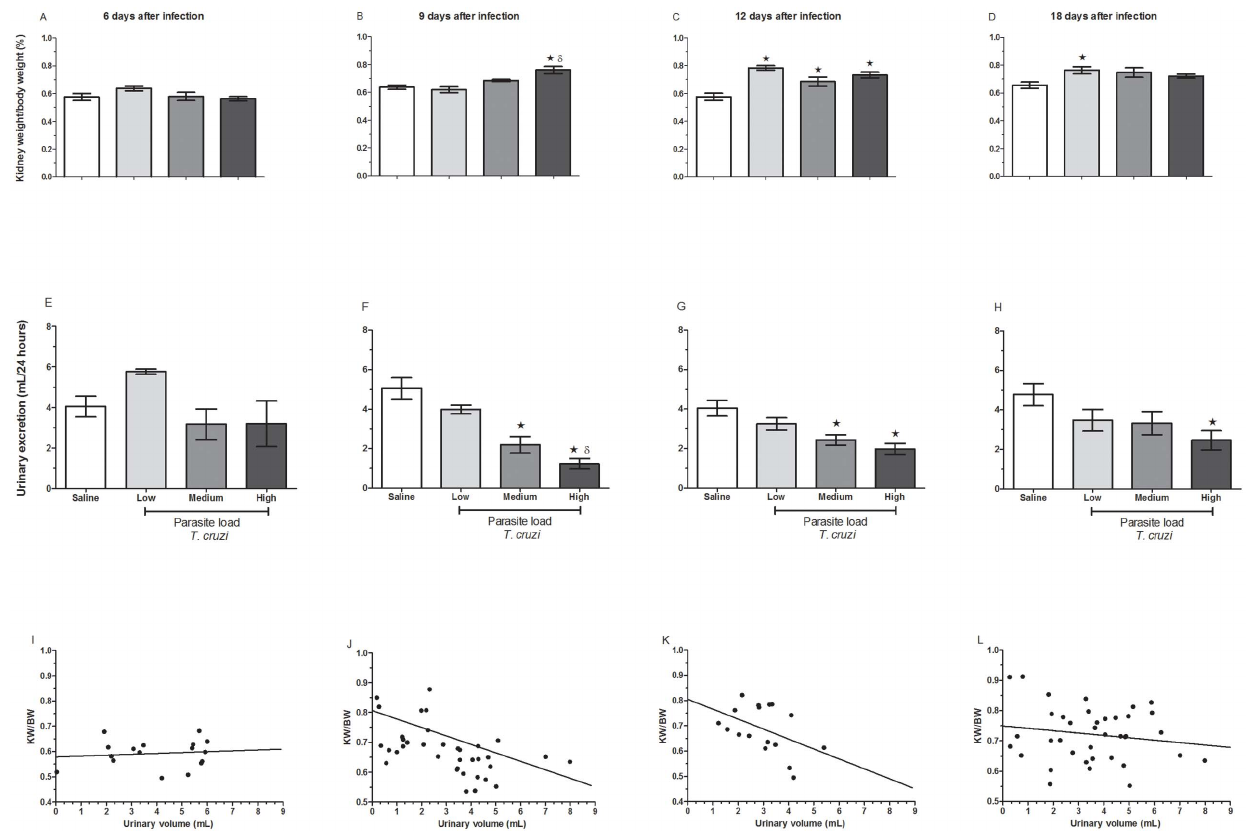
Figure 2. Determination of the urine excretion (24 hours) and the index between the kidney and body weight. The index between the kidney and body weight (A–D), urine excretion (E–H) and the correlation between the index and urine excretion (I–L) were evaluated as indicators of renal lesions. The bodies and kidneys of infected and uninfected mice were weighed at the indicated time points (6, 9, 12 and 18 days p.i.) to calculate the index. At the same time points, the animals were placed in metabolic cages for 24 hours to quantify the urine volume. *p # 0.05 indicates a significant difference between the animals that received a high inoculum and the uninfected animals. d p # 0.05 indicates a significant difference between the animals that received a high inoculum and the animals that received the low inoculum.